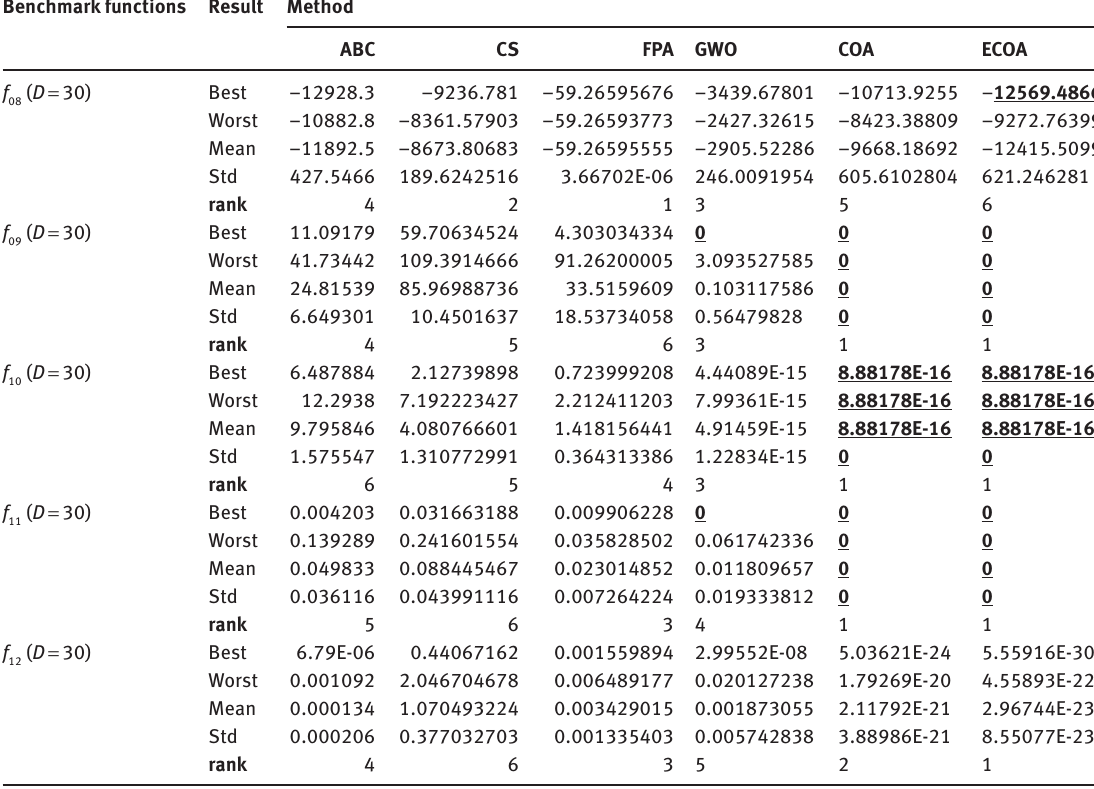
Table 3: Simulation Results for Test Functions f Benchmark functions Result Method